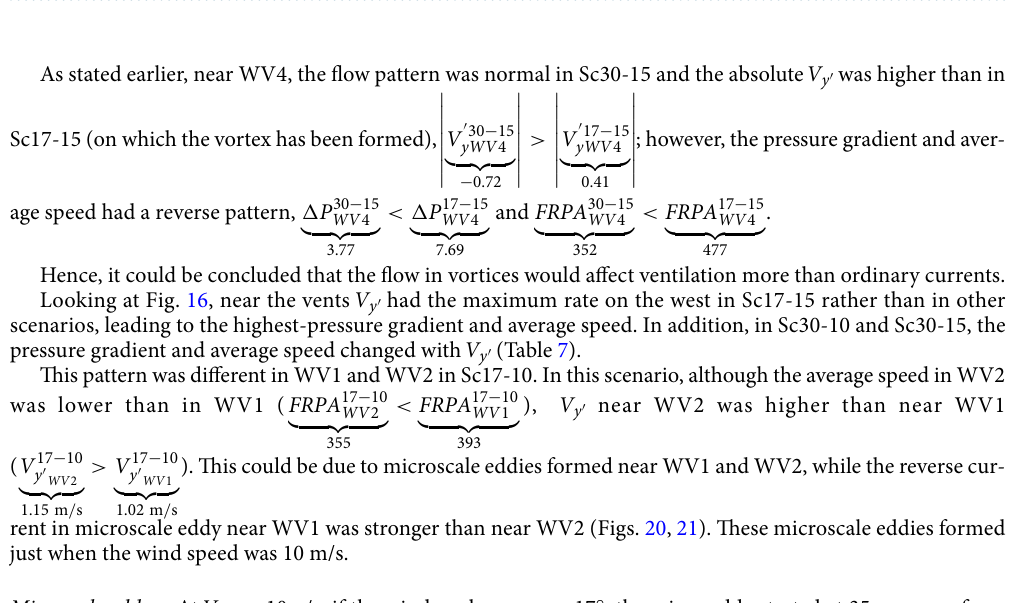
Table 7. Relation